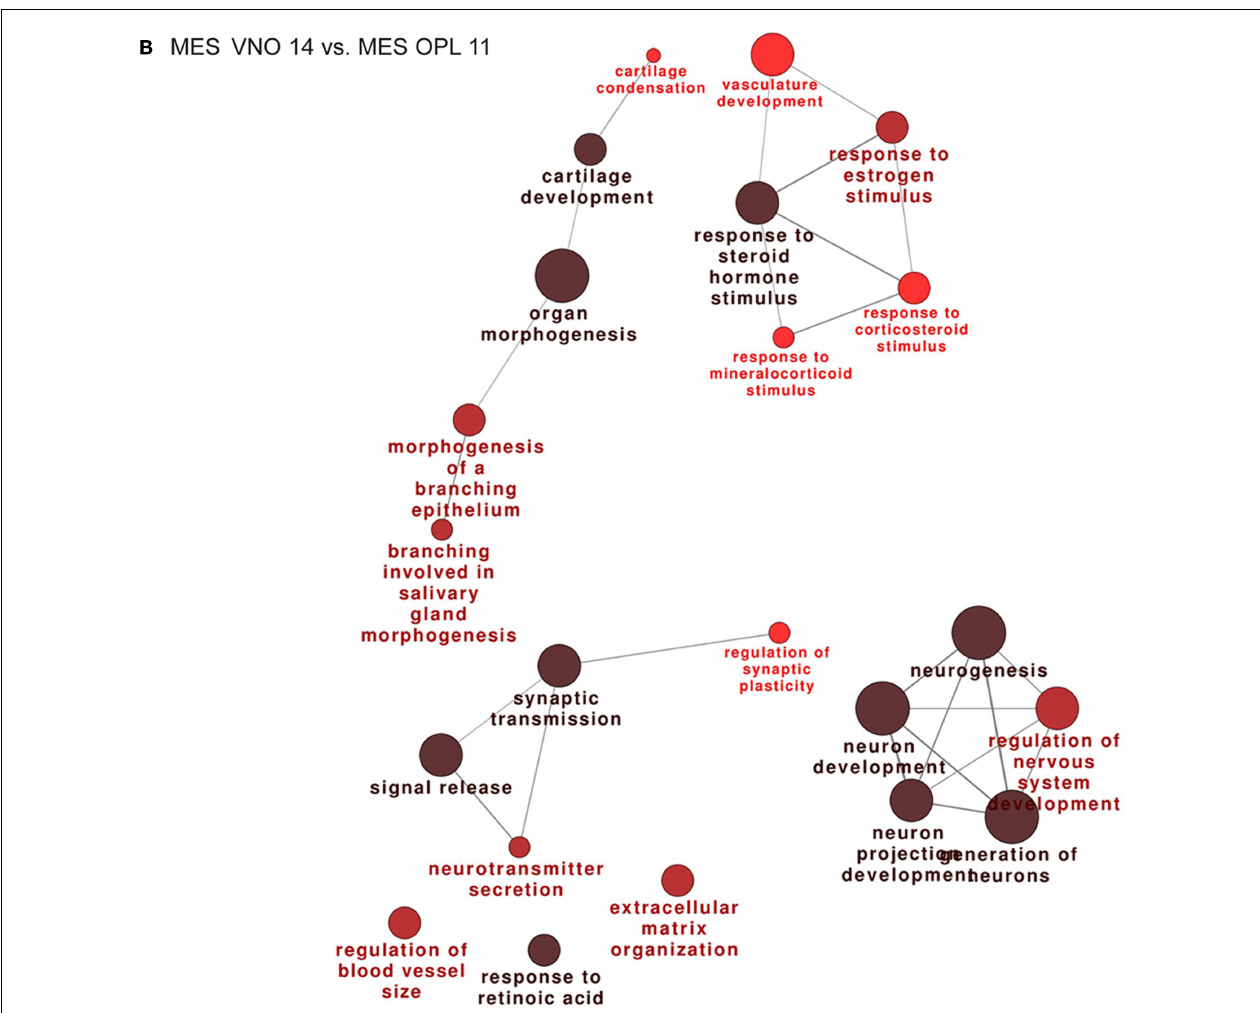
the mesenchymal tissue associated with the OE 14.5 vs. OPL 11.5 (A) or associated with theVNO 14.5 vs. OPL 11.5 (B) were organized in networks using ClueGO. Only the results of the up-regulated DEGs are